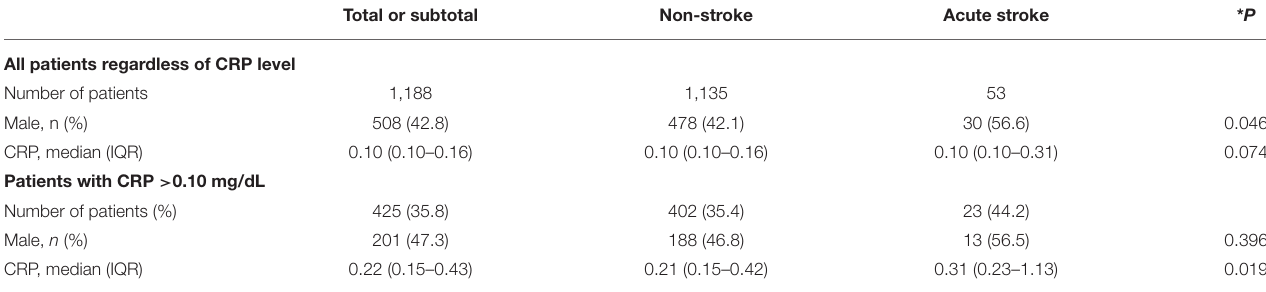
TABLE 2 | C-reactive protein levels in the study population stratified by stroke